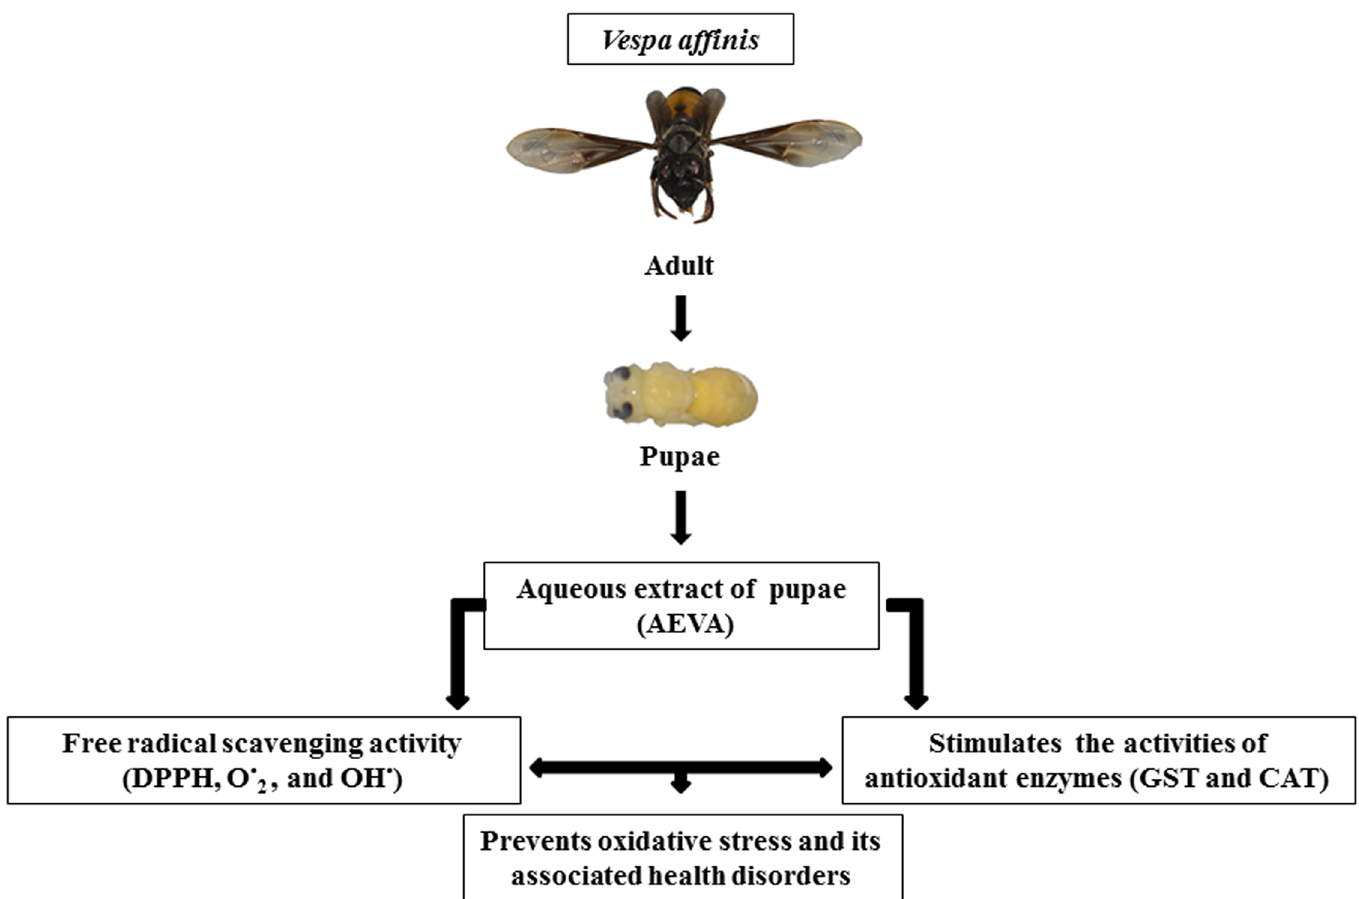
Fig 14. Flow diagram showing antioxidant potential of Vespa affinis